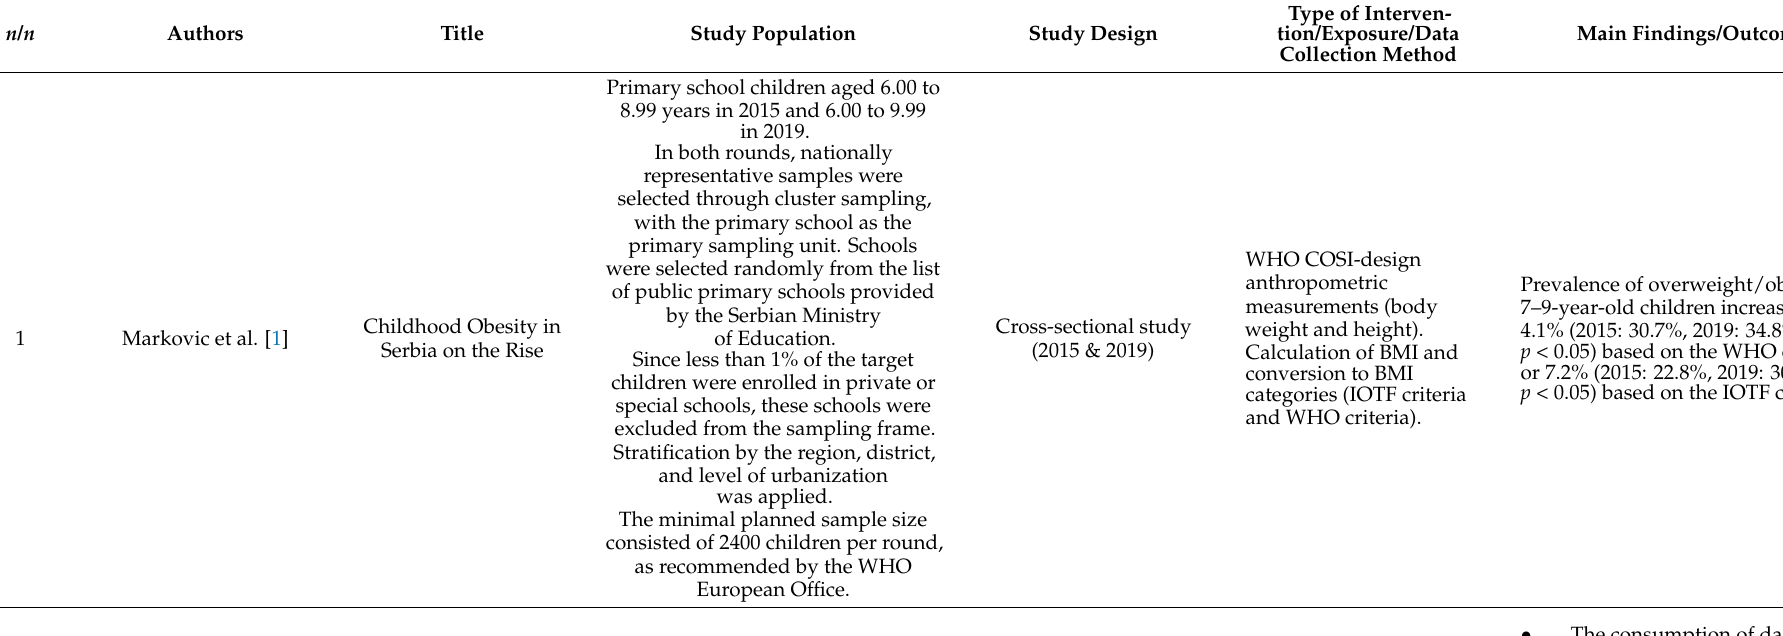
Table 1. Short description and main findings of the studies published in the Special Issue “Body Composition in Children” of the journal